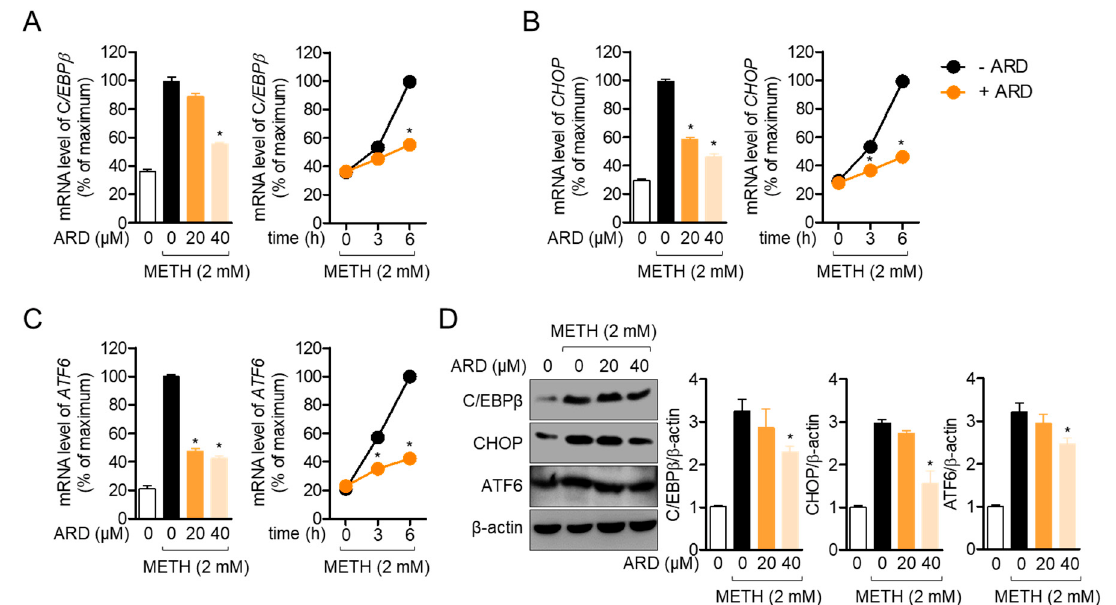
Figure 4. ( A – C ) SH-SY5y cells (1 × 10 5 /well, 6-well plate) were pre-treated with the indicated concentration (0 to 40 µ M) of aromadendrin for 1 h and exposed to 2 mM METH for 6 h (left panel) or the indicated time (right panel). After collection, cells were lysed for real-time quantitative PCR analysis. The expression levels of indicated genes were determined and normalized with the level of GAPDH . ( D ) SH-SY5y cells (1 × 10 5 /well, 6-well plate) were pre-treated with the indicated concentration (0 to 40 μ M) of aromadendrin for 1 h and treated with 2 mM METH for 24 h. Cells were harvested for Western blot analysis and indicated proteins were detected. The levels of indicated proteins were normalized with the level of β -actin. The mean value of three experiments ± SEM is presented. * p < 0.05 between METH-treated cells.